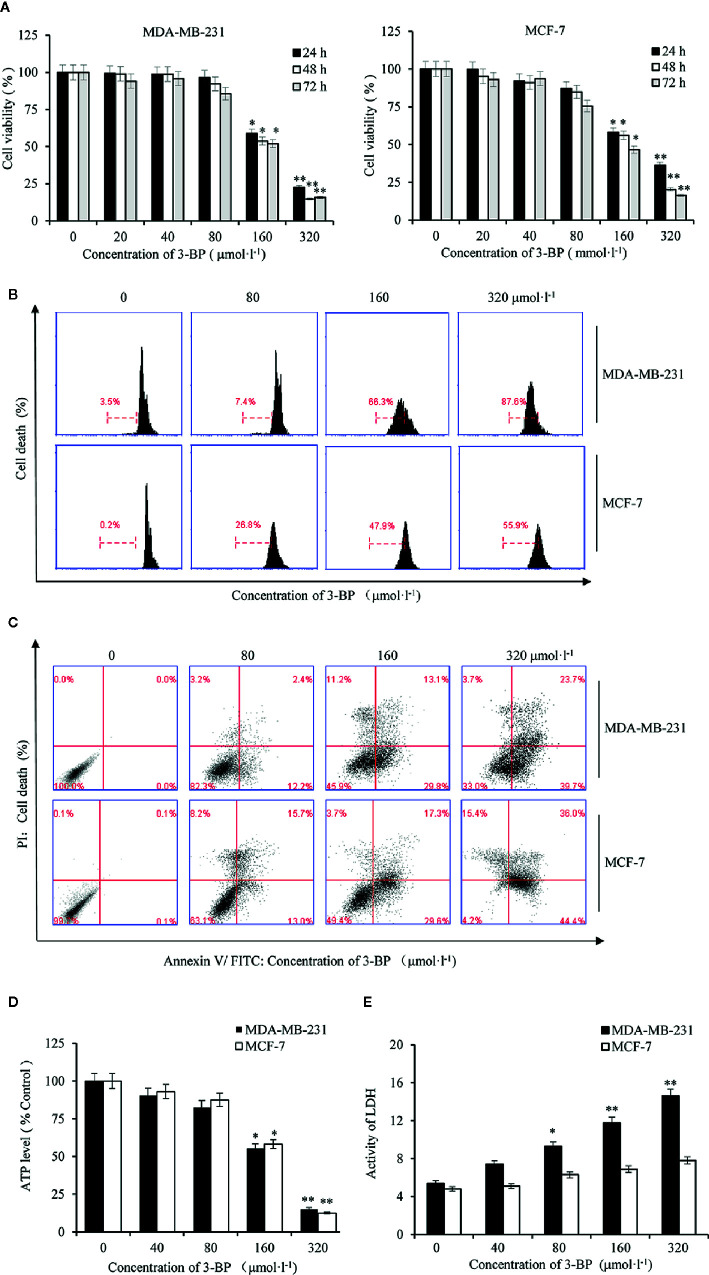
Inhibition effect of proliferation in breast cancer cells by 3-BP. (A) Breast cancer cells MDA-MB-231 and MCF-7 cells were treated with 3-BP (0, 20, 40, 80, 160, 320 μmol·l-1) for 24, 48, and 72 h. Cell viability was measured using the MTT assay. (B) The cell death rate in MDA-MB-231 and MCF-7 cells induced by 3-BP for 24 h. (C) Cell apoptosis induced by 3-BP in MDA-MB-231 and MCF-7 cells for 24h. (D, E). Reduction in ATP production and LDH level by 3-BP treatment, cells were cultured with 3-BP (0, 40, 80, 160, 320 μmol·l-1). Cellular levels of ATP were measured after 5 h. LDH level was measured after 24 h. *P < 0.05, **P < 0.01.